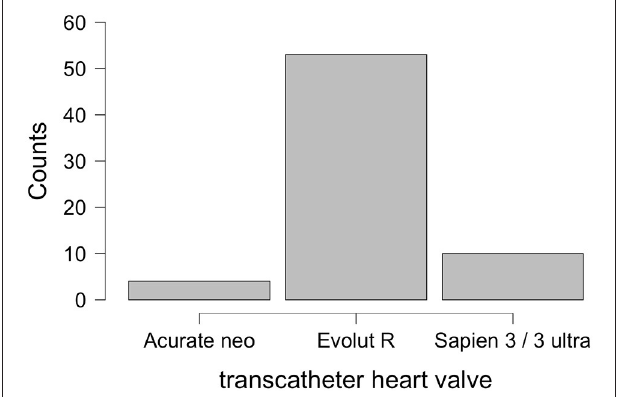
FIGURE 4 | Distribution of transcatheter heart valves in 67 ViV-TAVR.